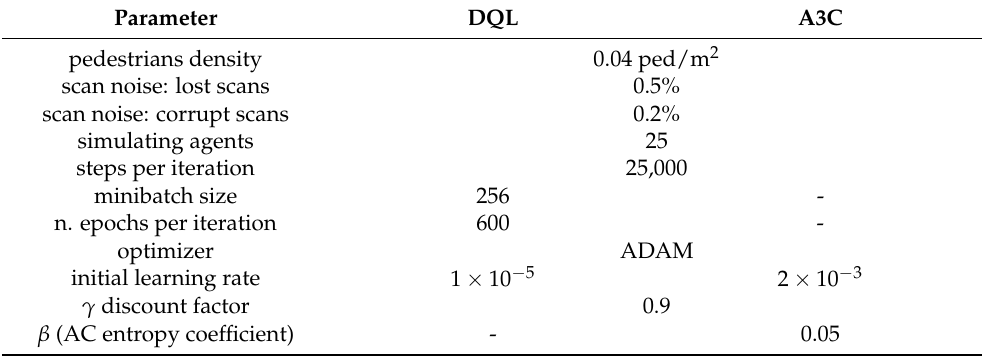
Table 2. Main simulation hyper-parameters used for the simulated environment and of the training of the